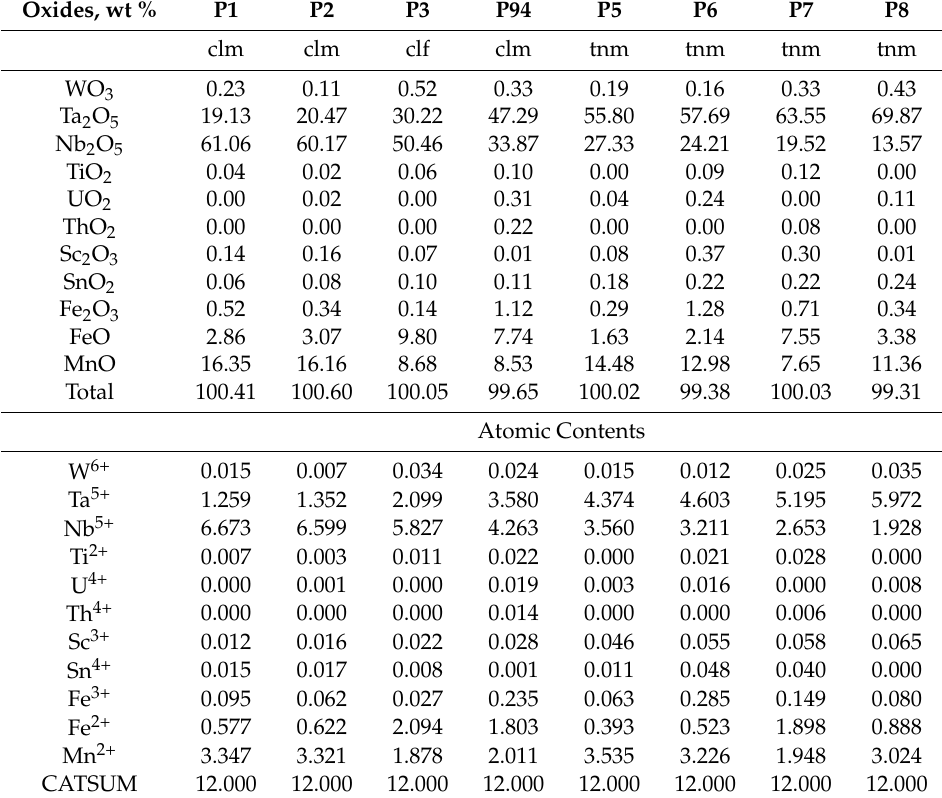
Table 1. Representative chemical composition of CGM from the Penouta open